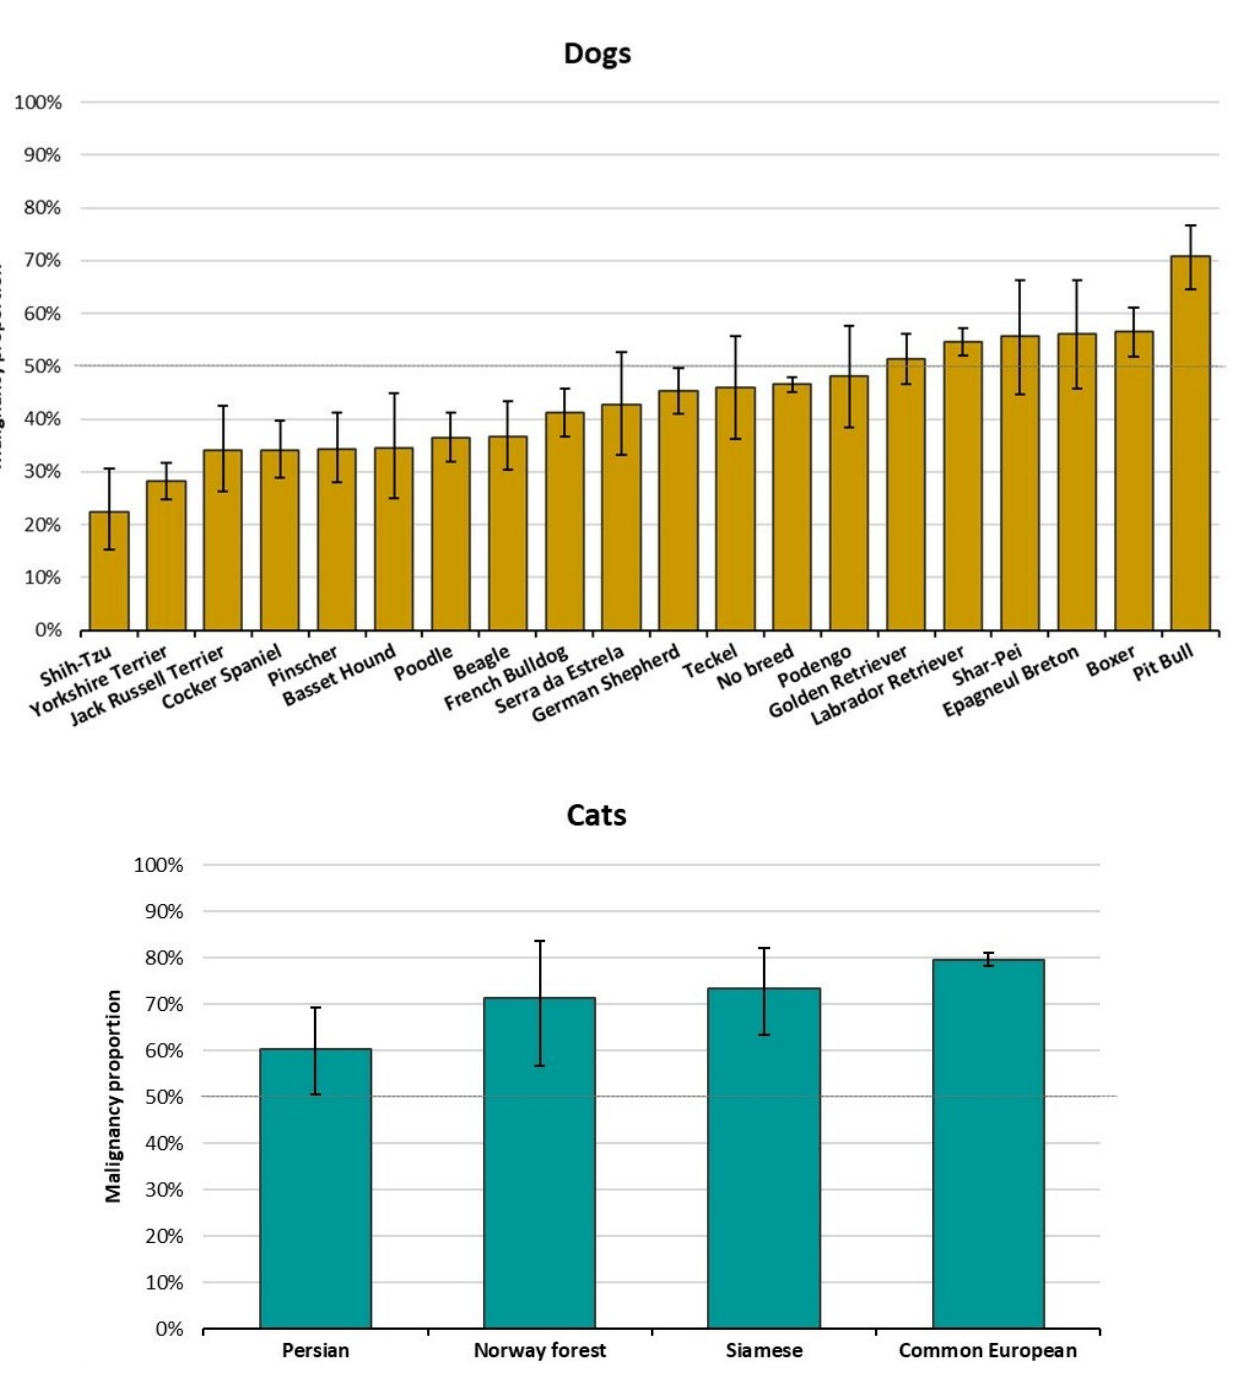
Figure 3. Malignancy proportion per main breeds of dogs ( top ) and cats ( down ). Bars indicate proportion of 95%CI. Dashed line depicts 50% of malignant tumors.